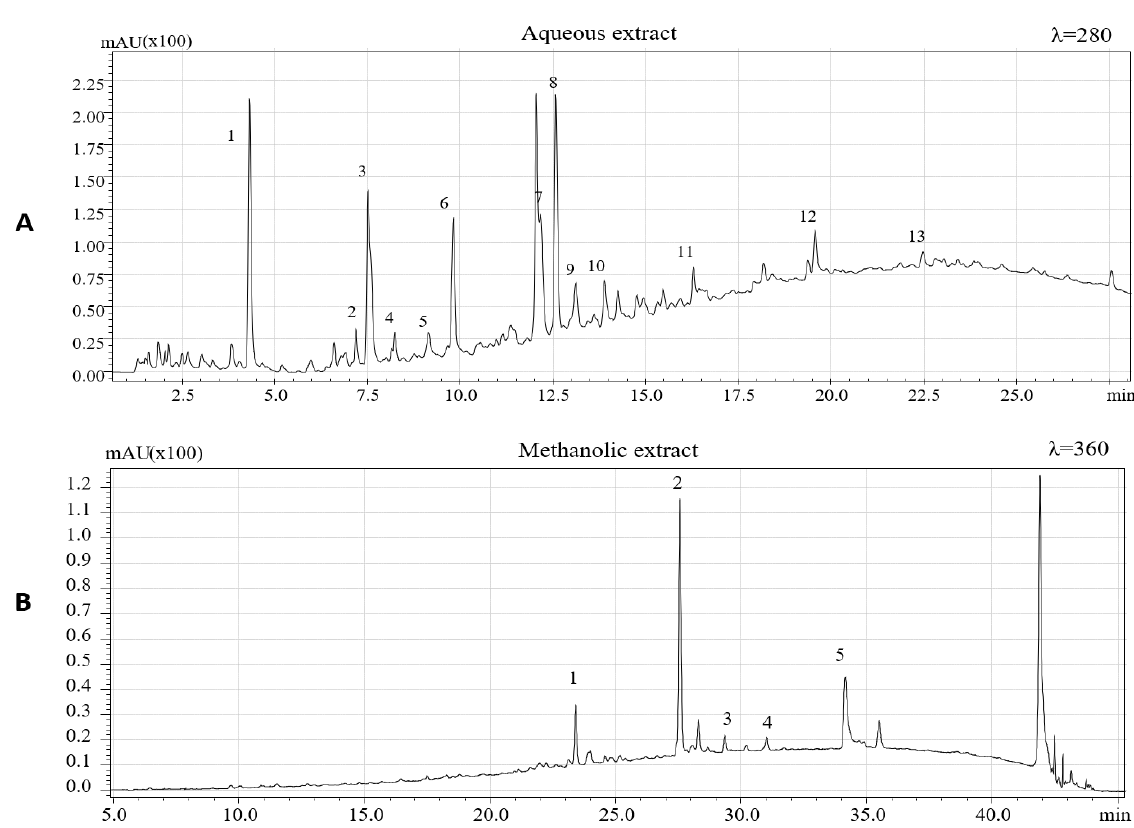
Figure 1. HPLC-PDA chromatograms of hazelnut skin extract: ( A ) aqueous extract ( λ = 280); ( B ) methanolic extract ( λ = 360). Peak numbers are referred to Tables 1 and 2. Table 1. Peaks identification of hazelnut skin aqueous extract through HPLC/ESI-MS.